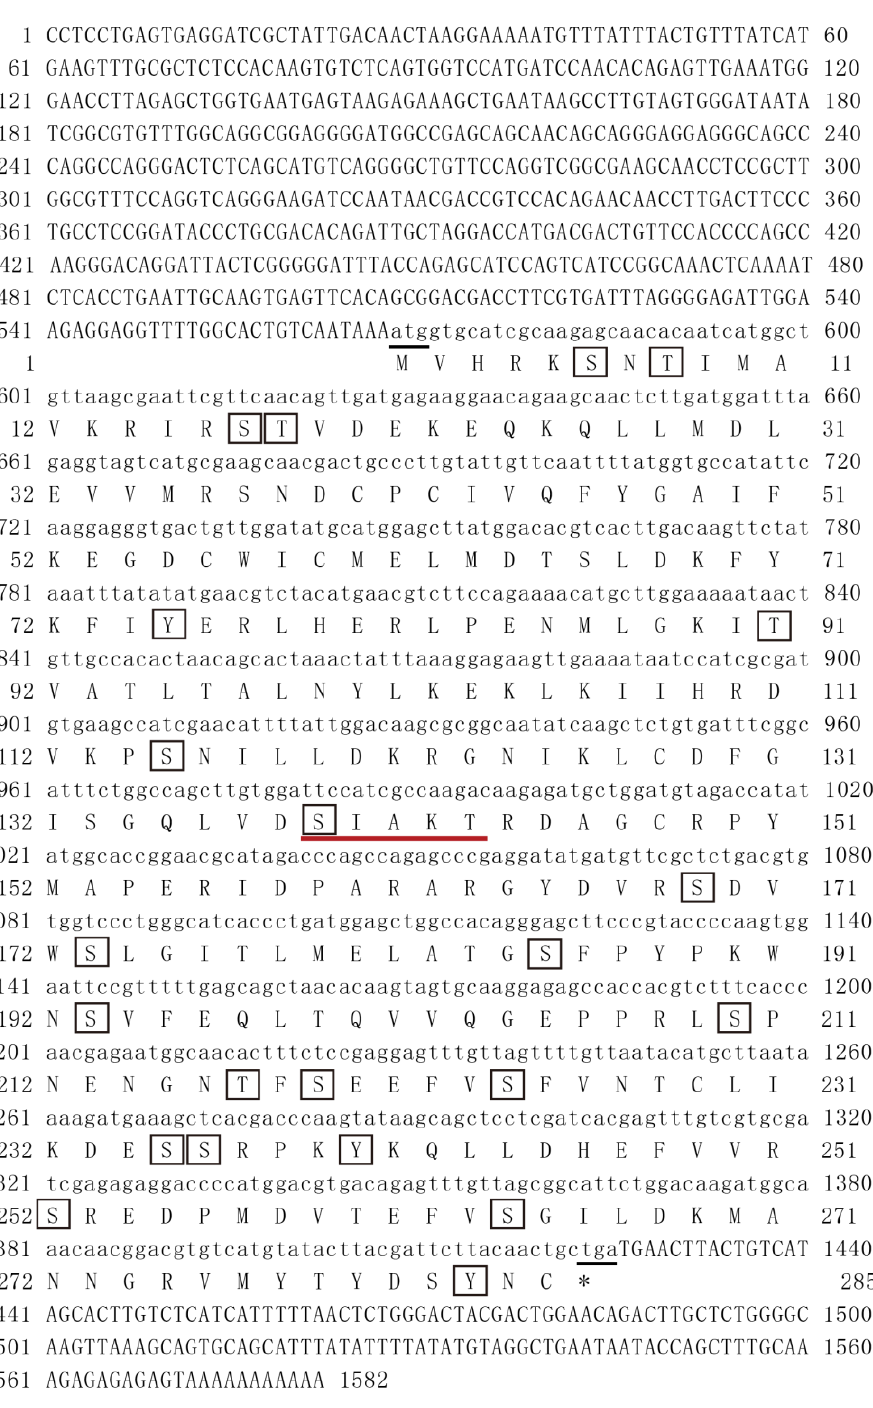
Figure 1. A schematic diagram of full-length cDNA of PmMKK4. The black underscore indicates the initiation codon (ATG) and termination codon (TGA), the black box indicates the phosphorylation site, and the red underscore indicates the “S– I – A – K –T” kinase region.